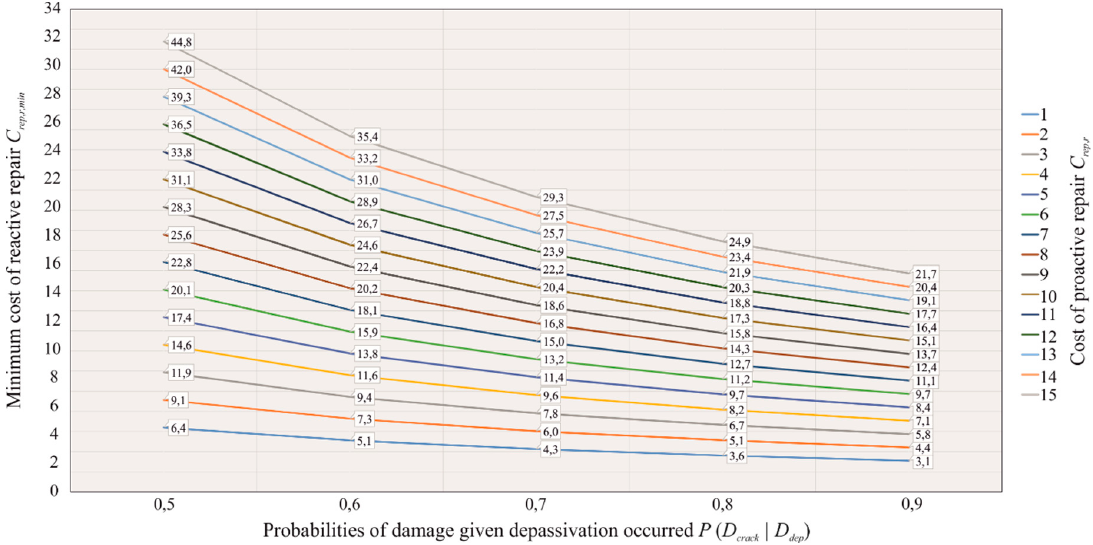
Figure 4. Minimum cost of reactive repair, C rep,r,min , for different probabilities of damage once the depassivation occurred, P ( D crack | D dep ), given the cost of measurement, C meas = 1, and the probability of depassivation, P dep = 0.6.